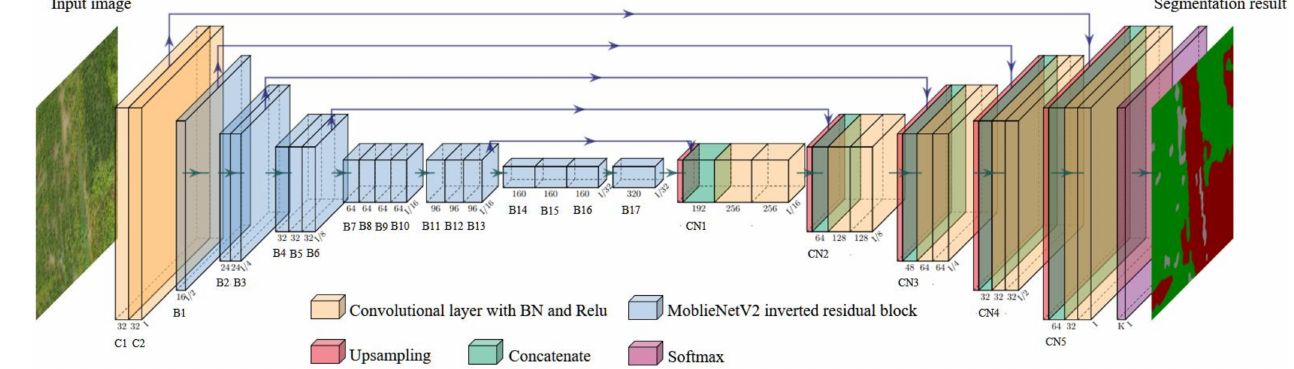
Figure 6. The structure of the MobileNetV2-UNet semantic segmentation model proposed in this